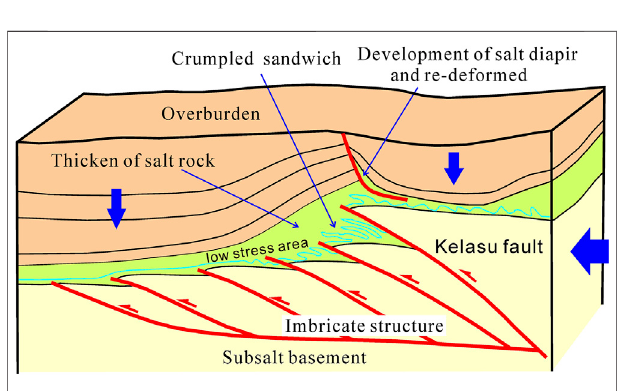
FIGURE 9 | Deformation model of the dolomite interbeds in the Kelasu structural belt; the crumpled data from Yang (2017).